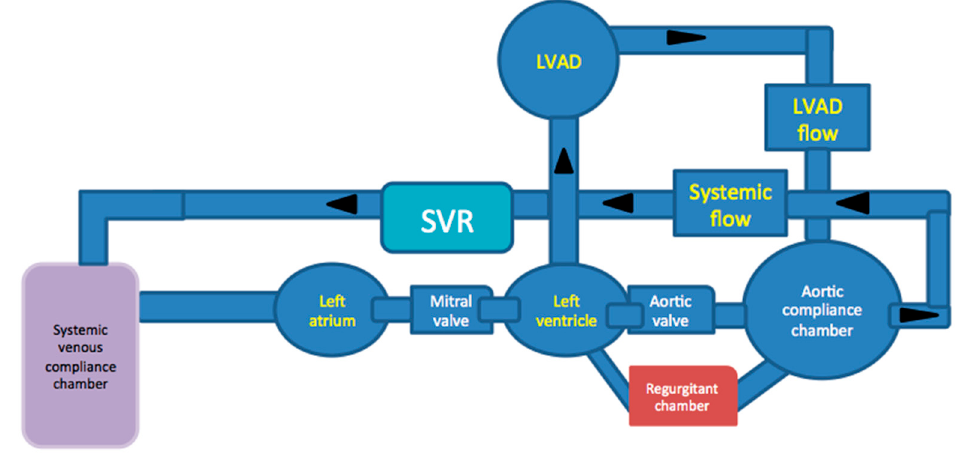
Figure 6. An example of a flow circulatory flow loop with LVAD connected to compliance chambers and flow meters.